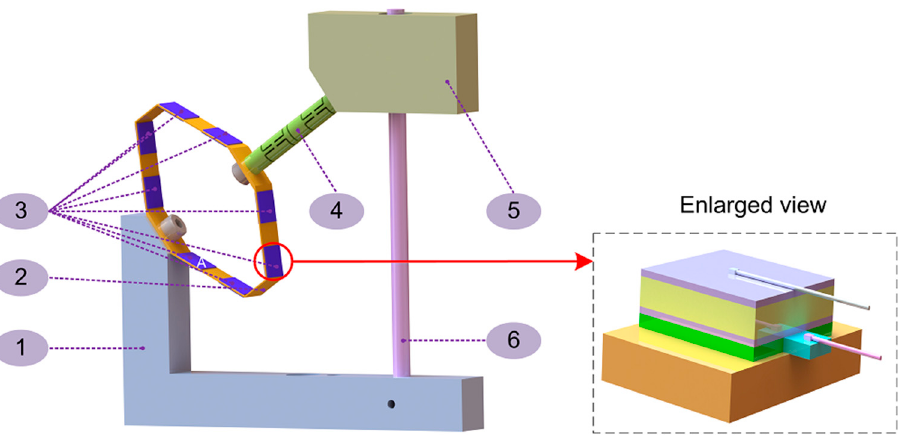
Figure 1. The overall schematic diagram of the generator and the enlarged view of the piezoelectric layer. Key components are listed as follows: 1. Base. 2. Leaf spring. 3. Piezoelectric layers. 4. Flexible hinge. 5. Workload. 6. Linear bearing guide rod.